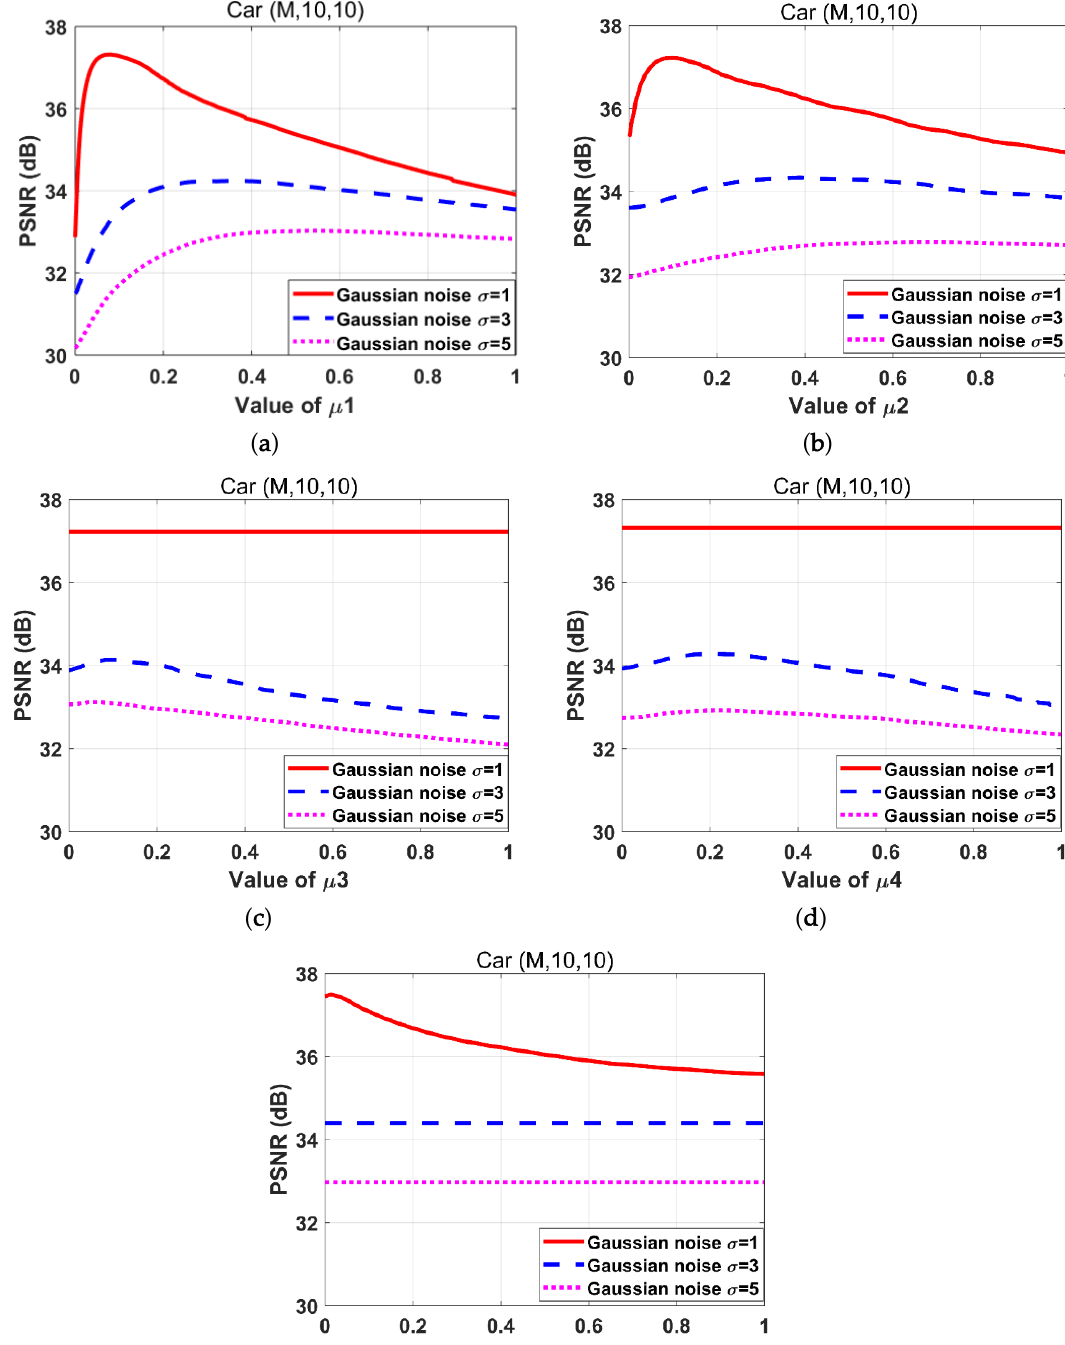
Figure 3. Effects of variations on the peak signal-to-noise ratio (PSNR) for the “Car” images degraded by the motion blur kernel (M, 10, 10) with Gaussian noise standard deviations 1, 3, and 5 respectively.